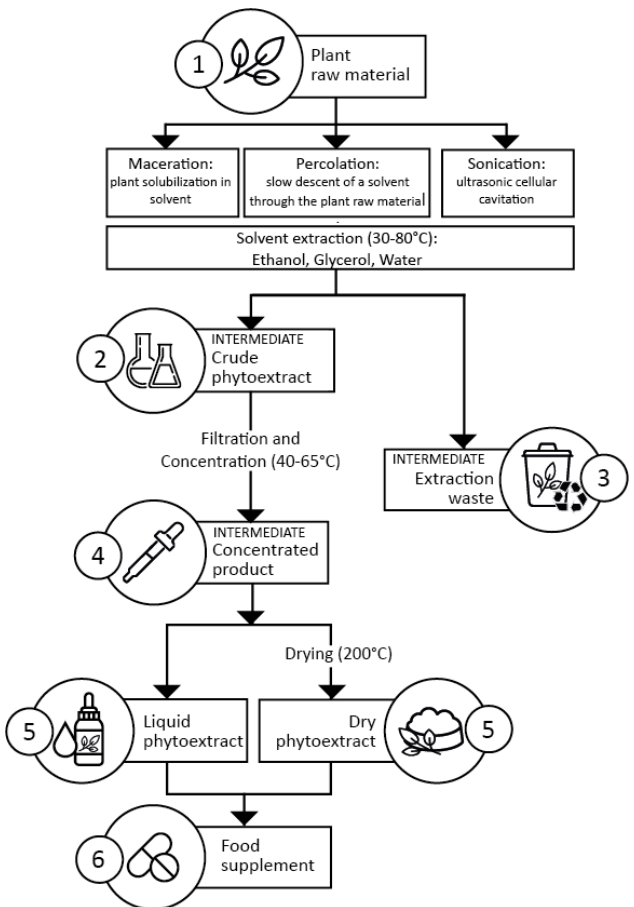
Fig. 1: The industrial flowchart of MAPs production. The numbers indicate the intermediate steps of the industrial process for which the DNA barcoding efficacy has been verified (Tab.